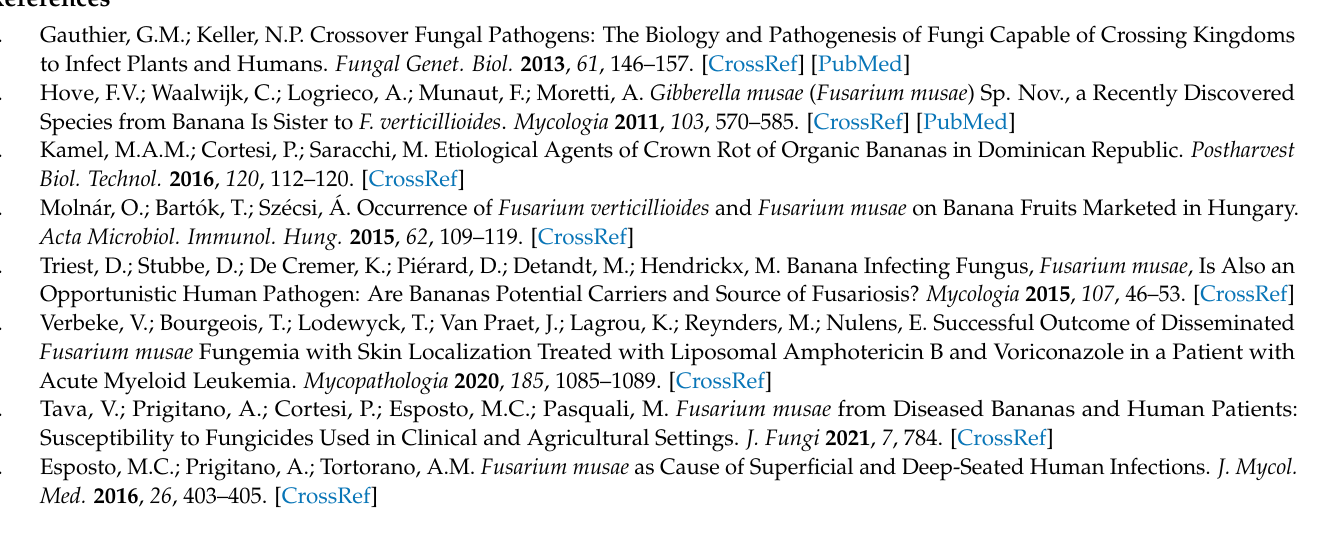
Table S3: Endonuclease identity in all F. musae strains; Figure S1: Whole nucleotide alignment